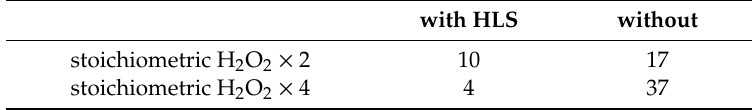
Table 2. Removal of PCP (1 mg / L) by photo-Fenton driven under simulated sunlight with Pyrex filter with, and without, HLS and with extra amount of hydrogen peroxide. The t 50% are given in min.